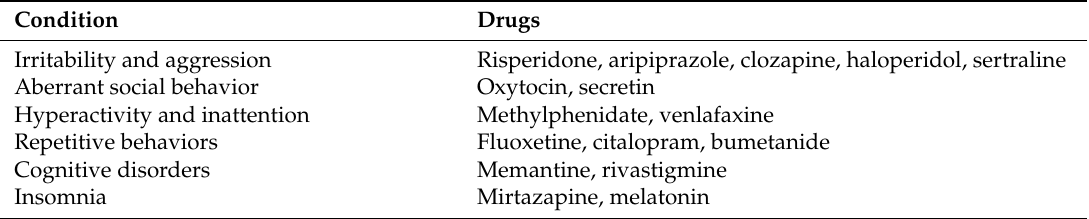
Table 3. Autism spectrum disorder medications (modified from LeClerc et al.